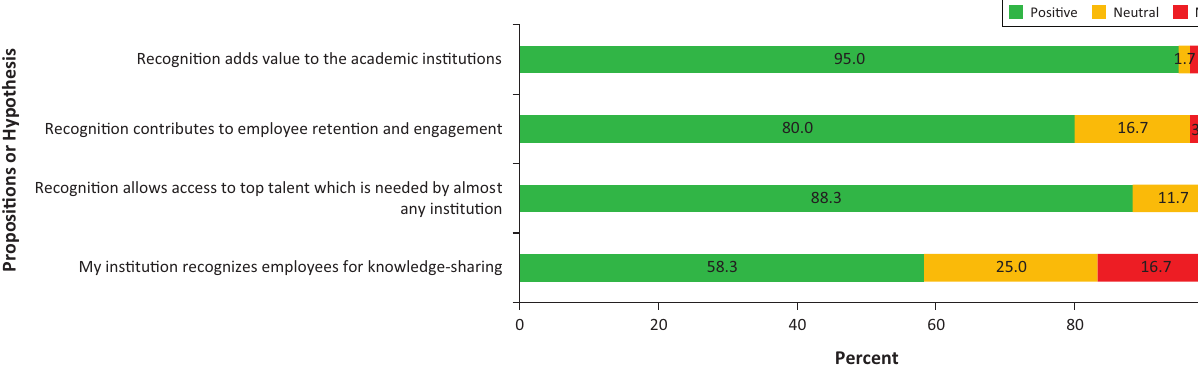
FIGURE 2: Recognition for knowledge-sharing in higher education institutions ( n = 60).